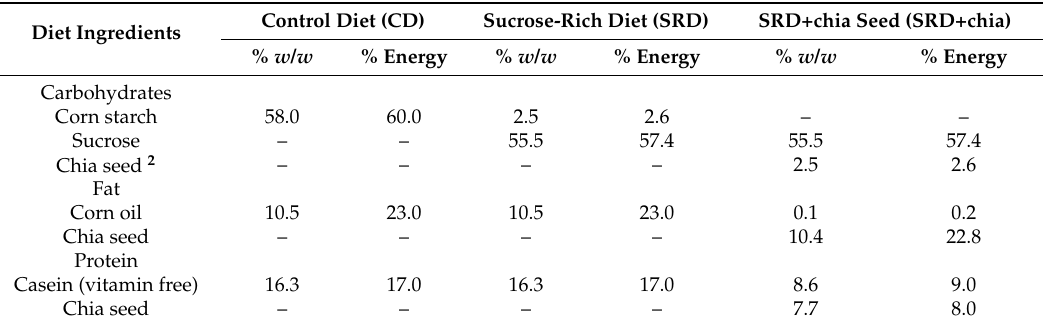
Table 1. Composition of experimental diets 1